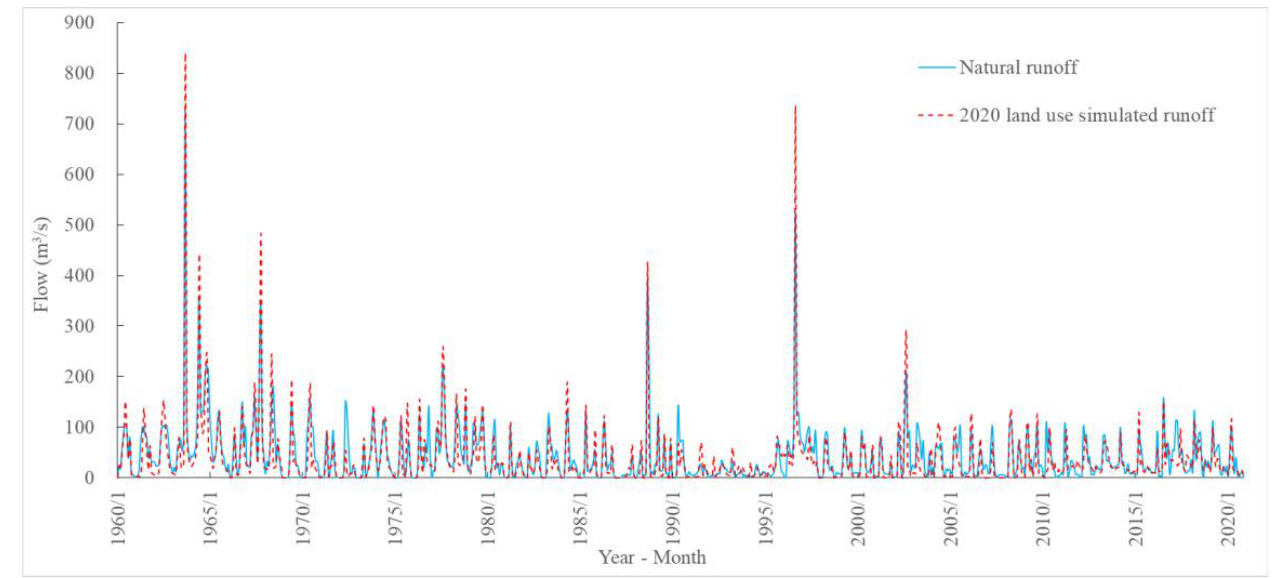
Figure 6. Comparison of simulated and natural runoff under the land-use scenario of 2010 at the Huangbizhuang Station.